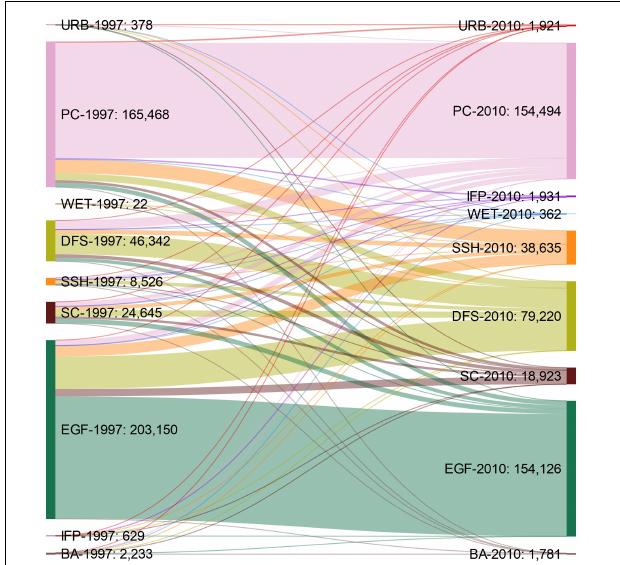
FIGURE 7 | Sankey diagram showing LULC change transitions for 1997–2010. LULC class frequency is reported in terms of km 2 . LULC classes include: (1) BA (Barren); (2) URB (Urban/Developed); (3) PC (Permanent Crops); (4) SC (Shifting Cultivation); (5) SSH (Scrub/Shrub/Herbaceous); (6) DFS (Deciduous Forest/Scrub); (7) EGF (Evergreen Forest); (8) IFP (Industrial Forest Plantation); and (9) WET (Wetland Cover). For additional descriptions of these LULC classes, see Table 1